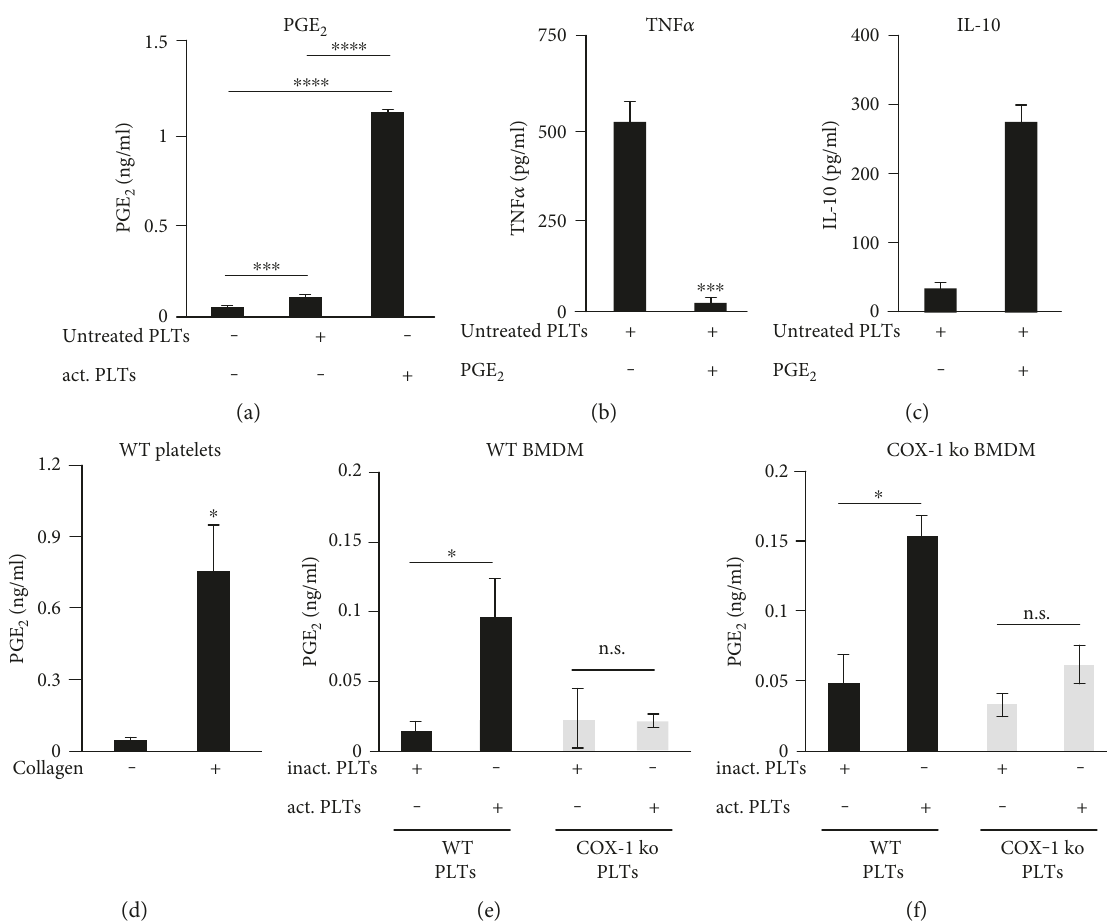
Figure 2: Cross-regulation of PGE and TNF α through an induction of IL-10 in murine macrophages by platelet derived PGE 2 BMDM were incubated alone, with untreated platelets, or with collagen-activated platelets for 3 hours. (b), (c) Murine BMDM were incubated with untreated platelets with or without PGE (1 μ M) for 3 hours. (d) Murine platelets were incubated with or without collagen (1 μ g/ml) for 2 30 minutes. (e), (f) BMDM from wild-type mice (b) or COX-1-de fi cient mice (c) were coincubated with BAPTA-AM-inactivated platelets (30 μ M) or with collagen-activated platelets isolated from wild-type and COX-1-de fi cient mice for 3 hours. The concentrations of PGE the medium were determined by LC-MS/MS. IL-10 levels and TNF α levels in the medium were determined by ELISA. Data are presented as mean ± SEM from 4 experiments. One-way ANOVA/Bonferroni ∗ P < 0 05 , ∗∗ P < 0 01 , ∗∗∗ P < 0 002 , ∗∗∗∗ P < 0 0004